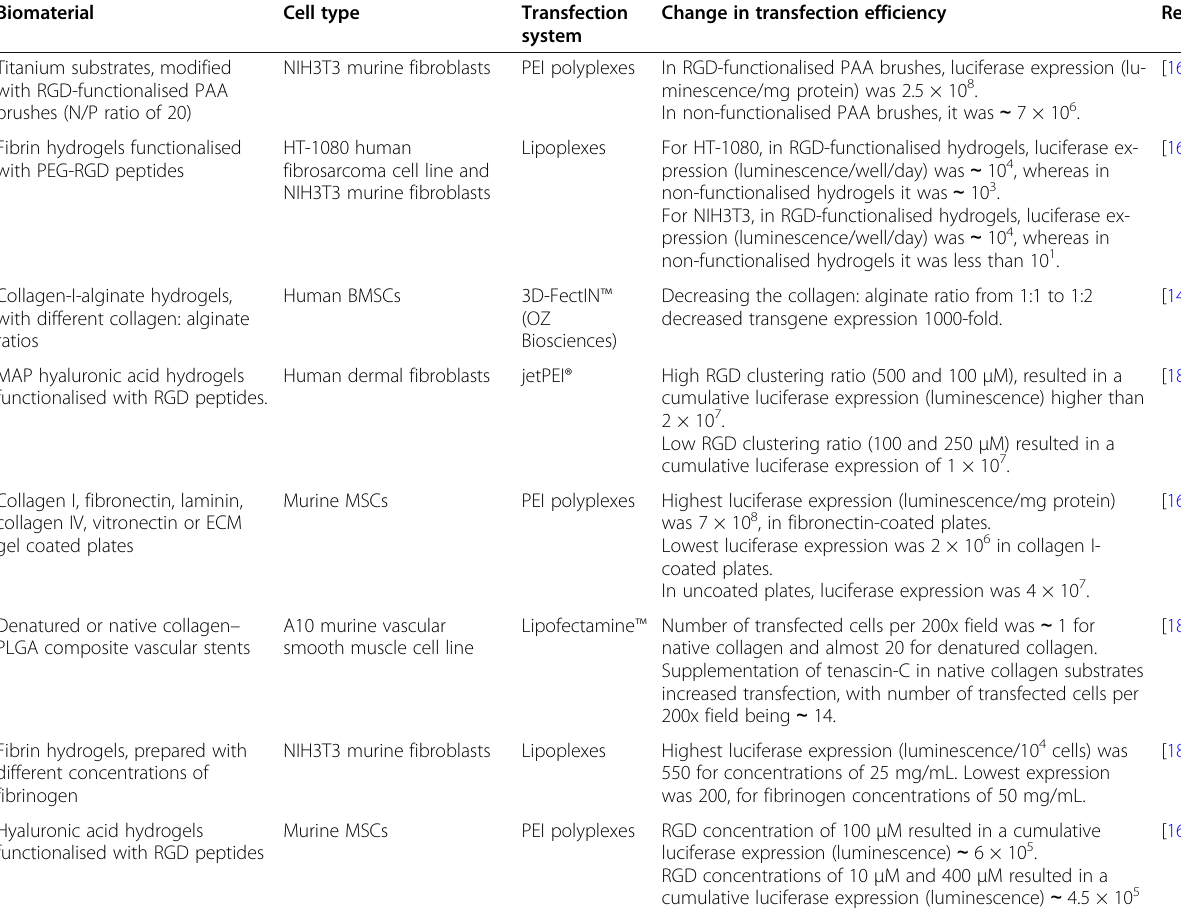
Table 3 ECM cues and gene delivery. Research papers assessing the effect of ECM cues on biomaterial-mediated gene delivery